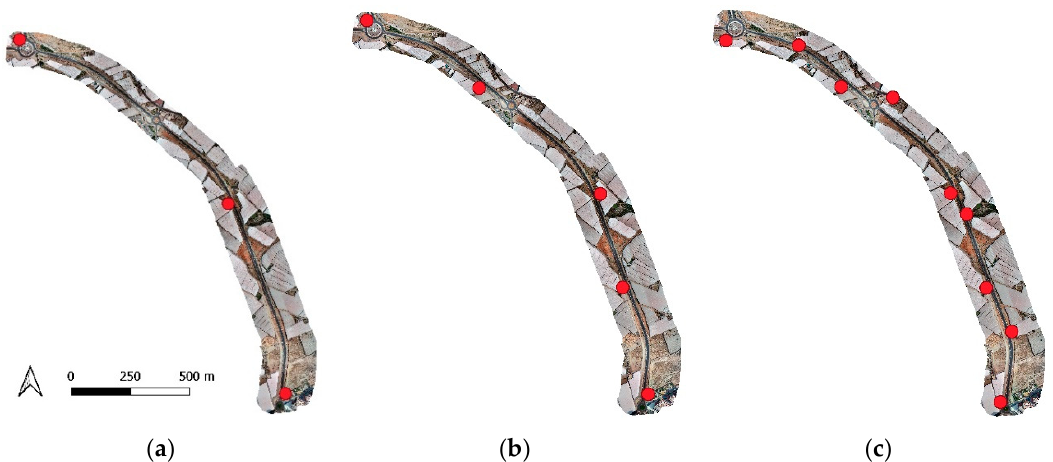
Figure 6. Location of the targets used as GCPs (red dots) for each project within Distribution 2. Three projects using ( a ) 3, ( b ) 5, and ( c ) 9 GCPs.